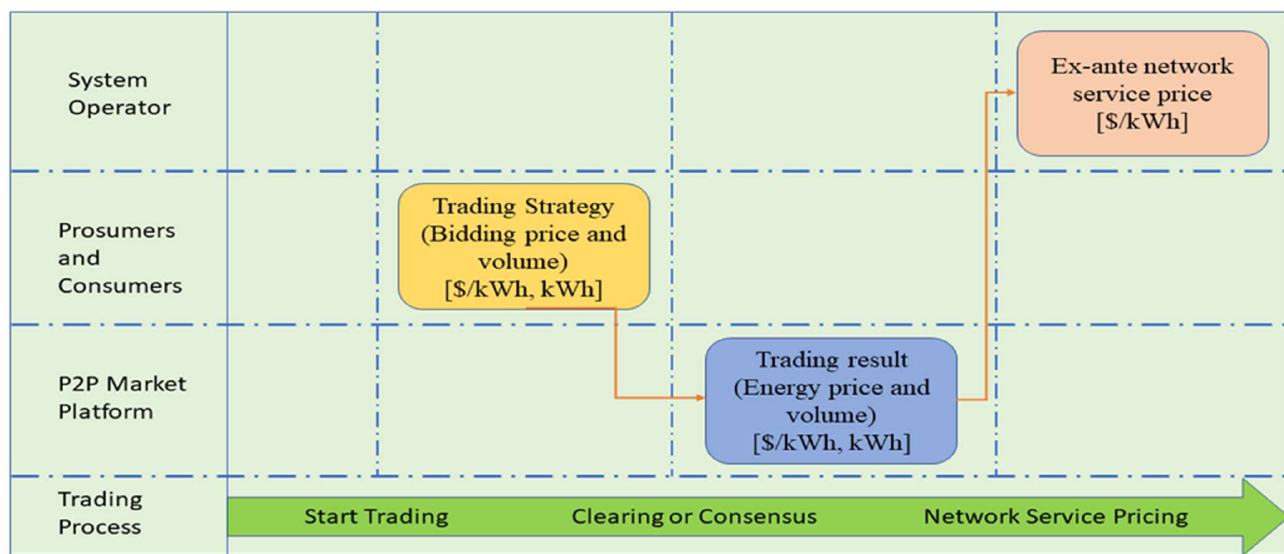
Figure 8. P2P energy trading process based on the ex-ante network service pricing.